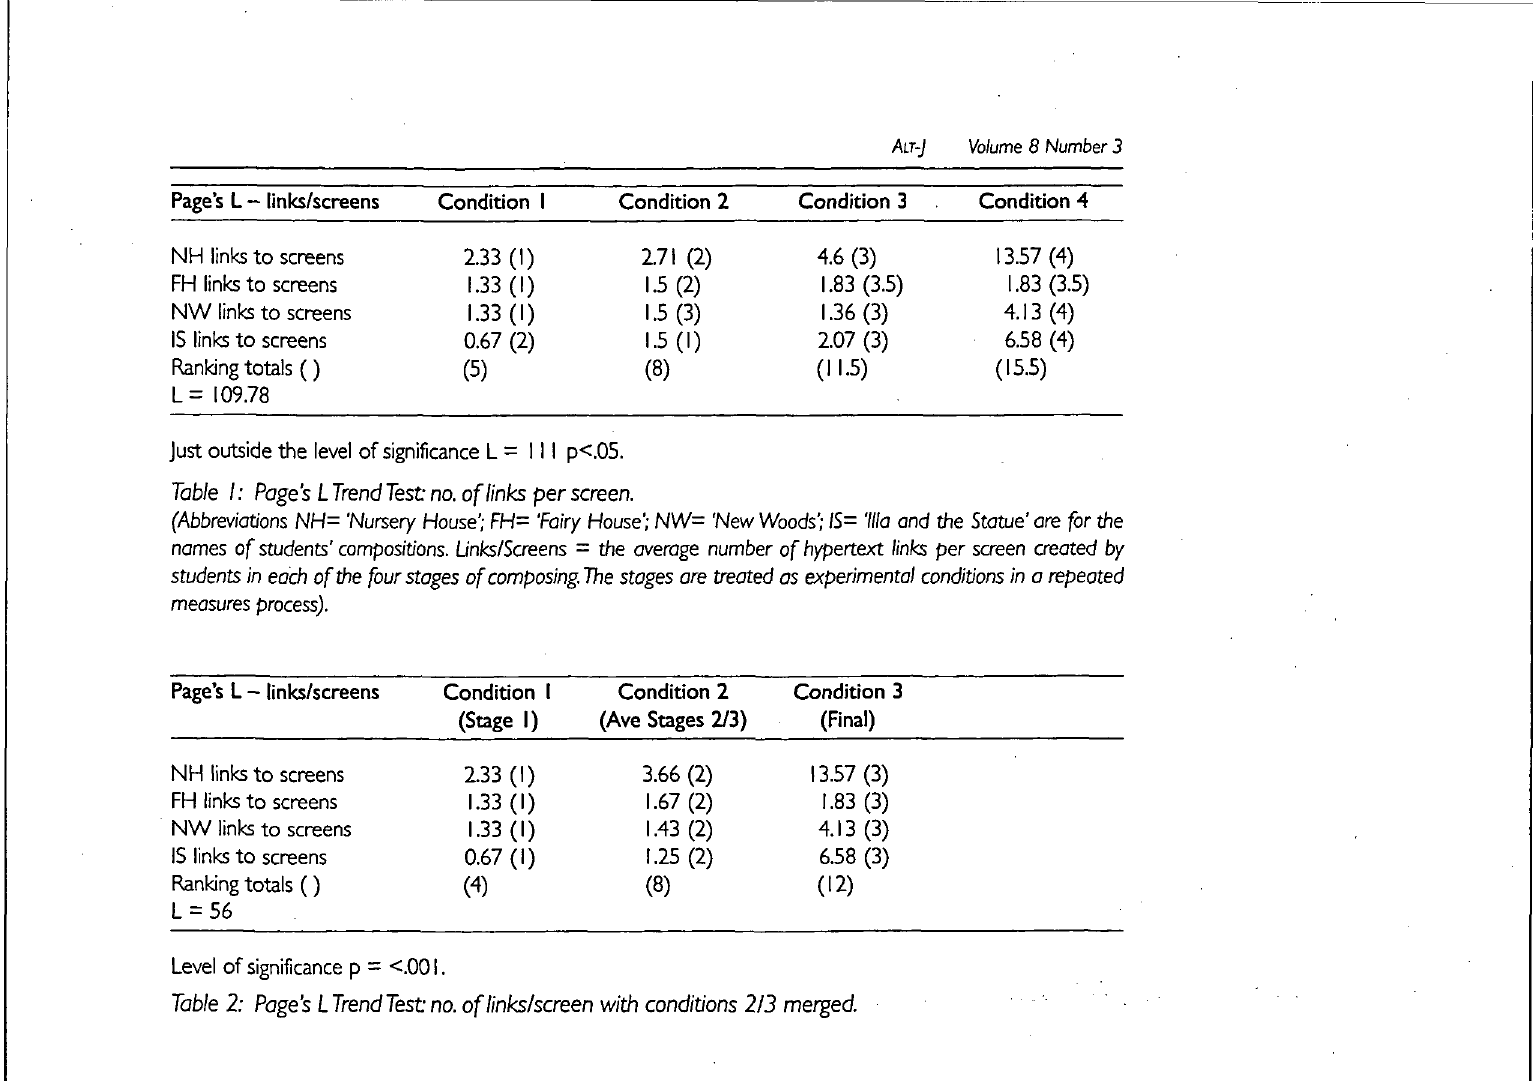
Table 2: Page's LTrendTest no. of links/screen with conditions 213